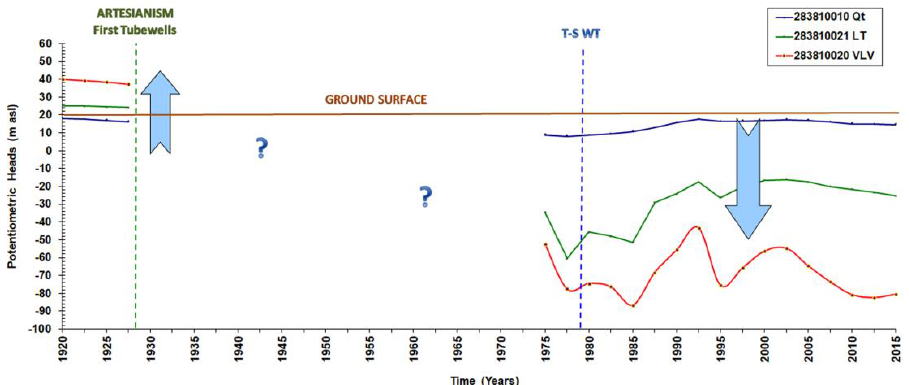
Figure 5. Long-term evolution of groundwater levels in the Quaternary (Qt), Pliocene (LT) and Messinian (VLV) aquifer layers. The arrows indicate the direction and relative magnitude of the vertical hydraulic gradient. The dashed green line indicates artesianism in the first tube wells in 1928. The blue dashed line indicates the beginning of the TSWT in